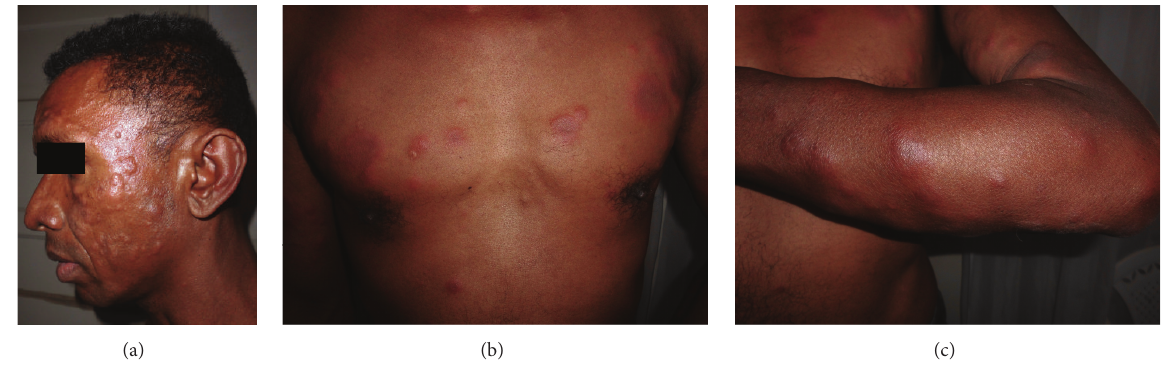
Figure 1: (a, b) Nodular lesions over face and trunk. (c) Nodular lesions over forearm.